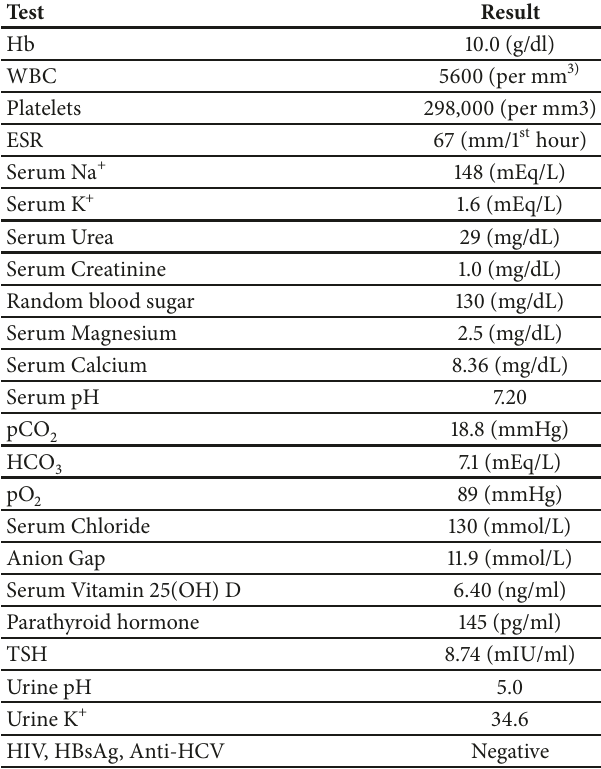
Table 1: Laboratory and biochemical parameters at